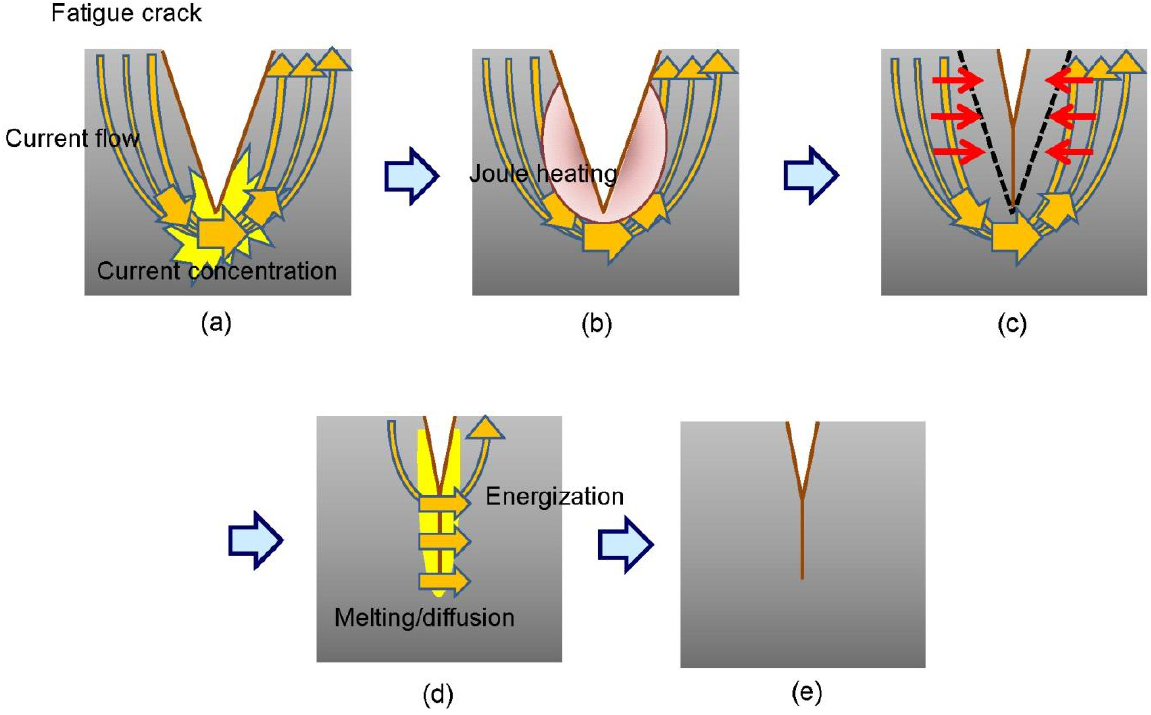
Figure 11. Representation of the crack closure process by the application of the electric current: ( a ) formation of a high-density electric current field at a crack tip; ( b ) local thermal expansion due to Joule heating; ( c ) crack closure resulting from thermal compressive stress; ( d ) bonding due to energization between the crack surfaces and ( e ) crack healing after the application of